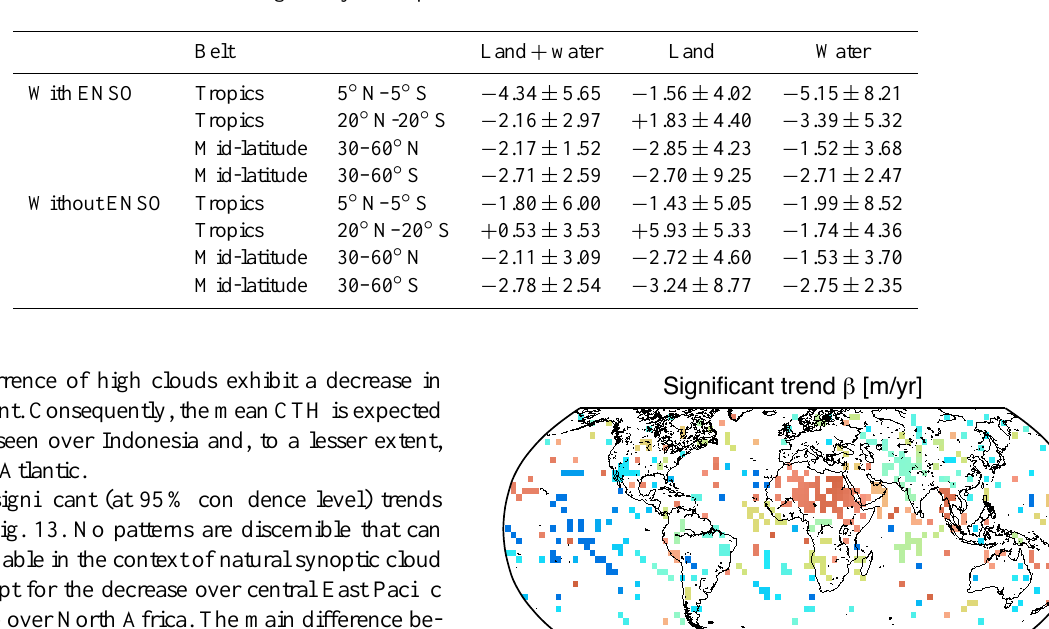
Fig. 6.9 shows global maps of trend magnitude β [ m / year ] in cloud top height anomaly (Fig. 6.9(a)) and standard deviation σ (Fig. 6.9(b)). σ is calculated with 100 bootstrap resamples for each β β 5 -sided cell grid. The number of resamples n is somehow arbitrary [ Mudelsee, 2010 ] . While n is not ◦